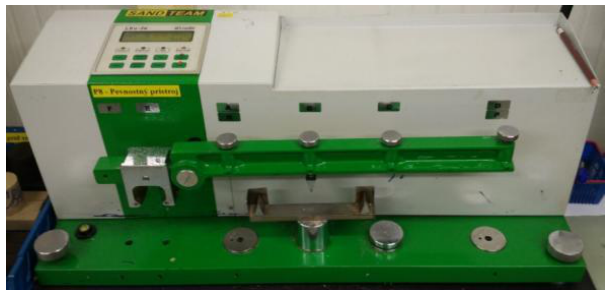
Figure 4. Universal strength machine Lru-2e.